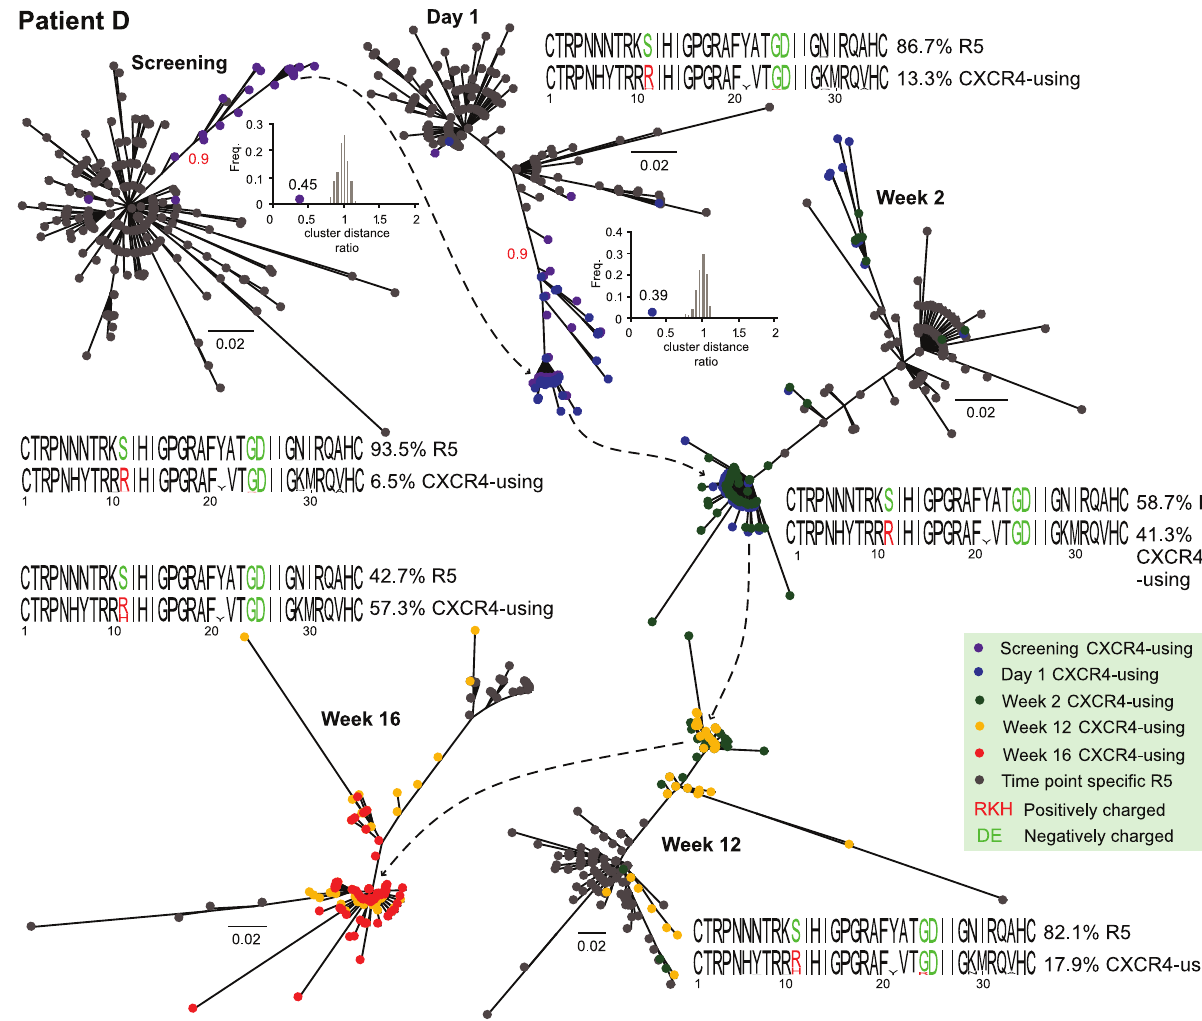
Figure 3. Evolutionary relationships of patient D’s viral population through time. Each phylogeny shows the predicted R5 and CXCR4- using variants for the time points: screening, day 1, week 2, week 12 and week 16; only unique variants are shown. Subsequent to screening, the CXCR4-using variants from the previous time point are included for visualization purposes. Sequence logos for R5 and CXCR4-using sequences for each time point are also shown. Colors (see key) indicate sampling time in phylogenies and residue charges in sequence logos. The red numbers on the lineage separating branches at screening and day 1 indicate the branch support value from the approximate likelihood ratio test for the distinct CXCR4-using lineage present at these time points. The inset plots indicate the extent of the clustering present for these same lineages and time points (value next to circle on x axis) in comparison to a distribution of randomly assigned clusters; see methods for further details. The scale bar represents nucleotide substitutions per